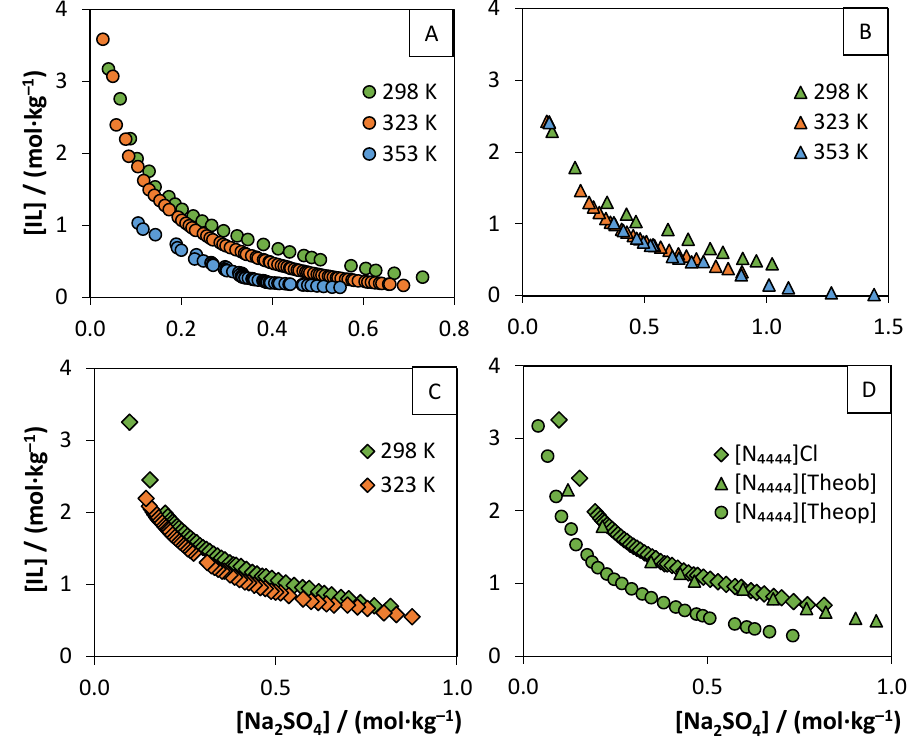
Figure 3. Binodal curves of the ternary systems, composed of ( A ) [N 4444 ][Theop], ( B ) [N 4444 ][Theob], or ( C ) [N 4444 ]Cl, water, and Na 2 SO 4 at 298 K (green), 323 K (orange), or 353 K (blue) ( ± 1 K) and atmospheric pressure (0.1 MPa). [N 4444 ]Cl was not tested at 353 K. ( D ) Comparison of the binodal curves of [N 4444 ][Theop] (o), [N 4444 ][Theob] ( Δ ), or [N 4444 ]Cl ( ◊ ) at 298 K, using Na 2 SO 4 as a salting- out agent.